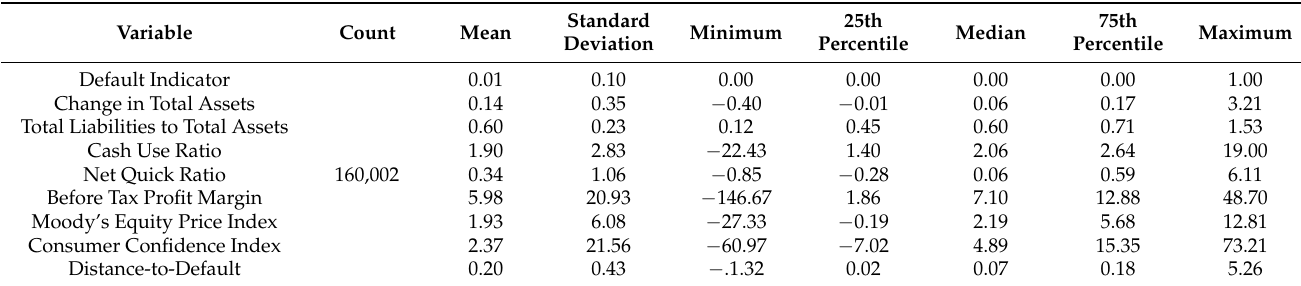
Table 4. Summary Statistics—Moody’s Large Corporate Financial, Macroeconomic, Merton/Structural Model Distance-to- Default Proxy Measure Explanatory Variables and Default Indicators: 1-Year PIT Model 2.